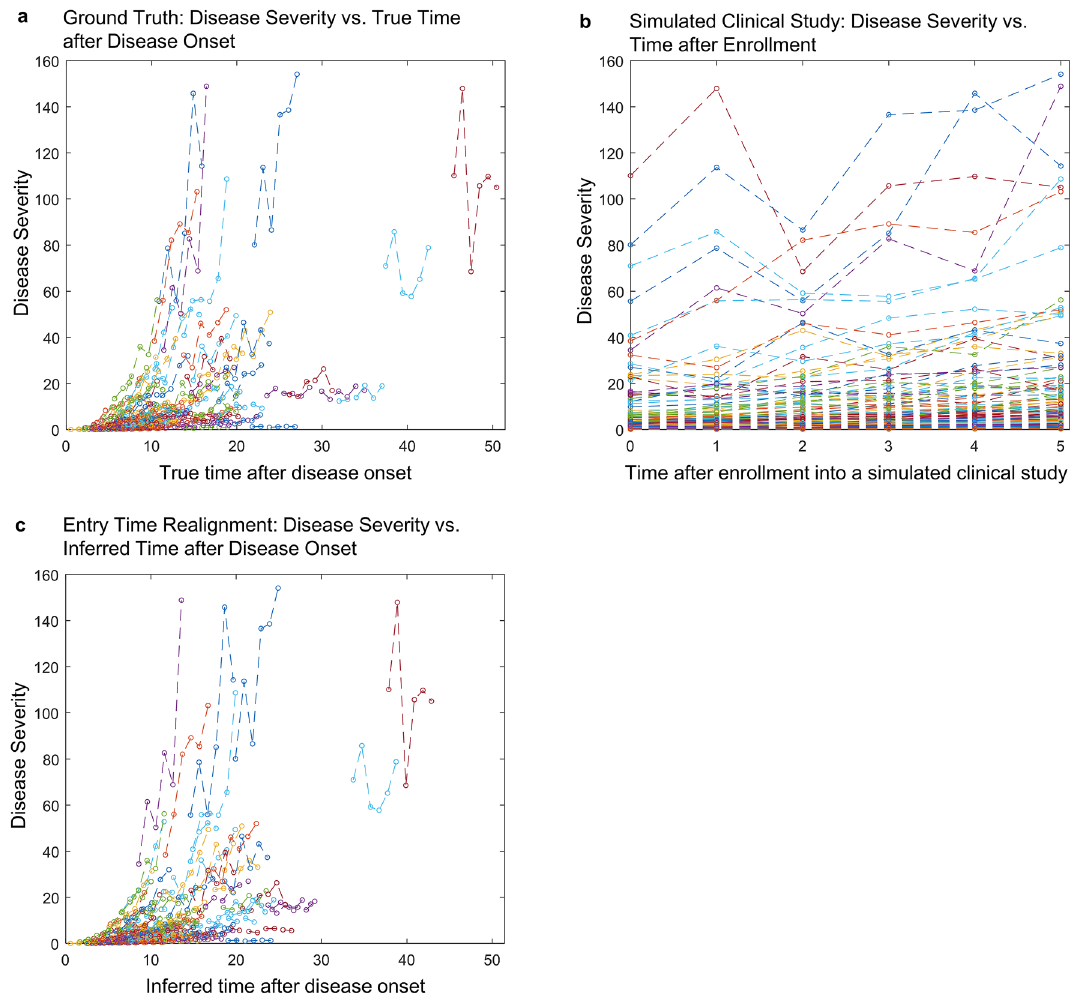
Figure 2. Bayesian entry time realignment (BETR) algorithm reconstructs the natural history of a disease in a simulated dataset. ( a ) Simulated natural disease progression over 5 years in 100 patients based on the second order model, serving as the ground truth. Each line represents the disease severity of an individual patient as a function of time after disease onset. The disease severity and time can have arbitrary units. In the simulation, different patients have different disease progression rates. ( b ) A simulated clinical study following the 100 patients over 5 years. In a typical clinical study, the durations of disease of individual patients are unknown so the horizontal axis is the time after enrollment into the study. ( c ) Reconstructed disease courses of the 100 patients based on applying BETR to the simulated clinical study datasets shown in ( b using different hypothesized disease progression functions, we calculated the deviance information criterion (DIC) for each function. DIC is Bayesian model comparison tool that balances model fit and complexity, where a lower value indicates that the selected disease progression model is preferred 24 . We found that the second order model achieved the lowest DIC among all competing models, including first order (DIC = − 110), second order (DIC = − 186), and exponential (DIC = 39). This suggested that the second order model was the best long- term disease progression model, consistent with the predefined ground truth f ( t ) . Next, we estimated β 1 i and δ i for each patient using BETR with second order disease progression function. After horizontally translating individual datasets in Fig. 2b by a factor of δ i , the horizontal axis was changed from time after enrollment into the study to inferred time after disease onset (Fig. 2c). The reconstructed disease natural history in individual patients was comparable to the ground truth (compare Fig. 2c with Fig. 2a), suggesting that BETR was able to reconstruct approximately 30-years natural history of a disease by realigning individual datasets followed over only 5 years. The estimated δ i were highly correlated with the true δ i , with an intraclass correlation coefficient (ICC) of 0.92 (Supplementary Fig. 1a,b). Similarly, the ICC between the estimated and true β 1 i was 0.92 (Sup- plementary Fig. 1c,d). We repeated the above simulation process 100 times for each ground truth model ( f ( t ) ). The ground truth models include: (1) first order model (different progression rates), (2) second order model (different progres- sion rates), (3) exponential model (different progression rates), (4) first order model (same progression rates), (5) second order model (same progression rates), and (6) exponential order model (same progression rates). The functional forms of the first order, second order, and exponential models were f